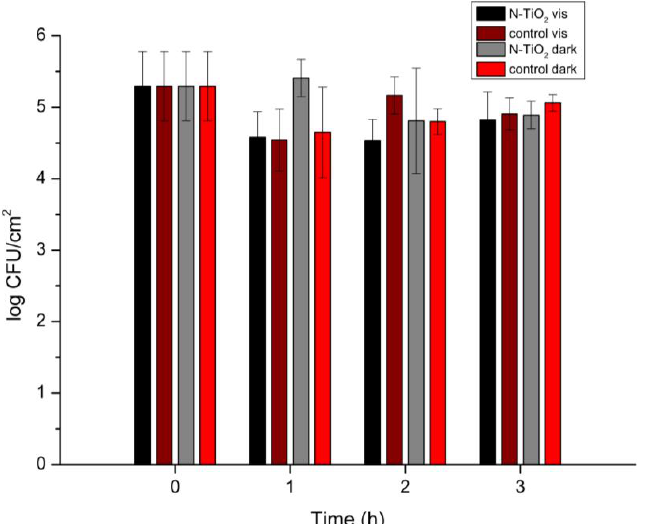
Figure 7. Salmonella Typhimurium biofilm population (log CFU/cm 2 ) with the presence of N-TiO 2 NPs under visible-light irradiation and in the dark for 0, 1, 2, and 3 h of irradiation. Control speci- mens are included (no N-TiO 2 presence), and the reported data are the mean values of two replicates with three samples each, ± standard deviation.